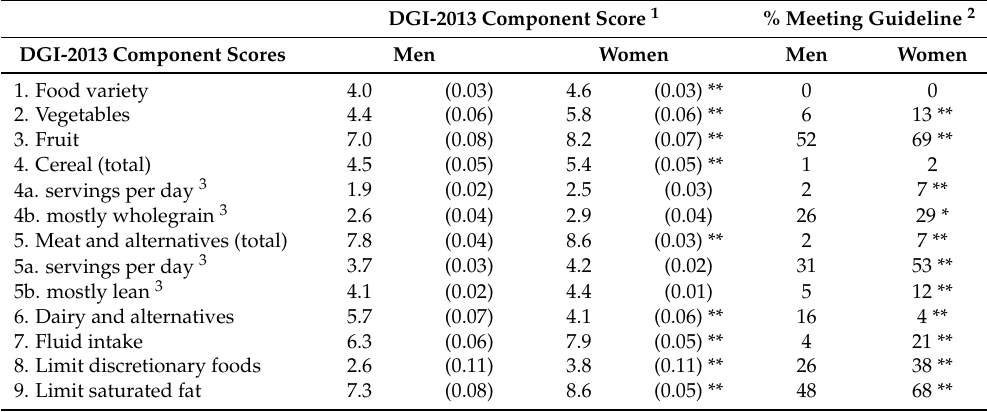
Table 3. Mean and standard error 2013 Dietary Guideline Index component scores and percent meeting dietary